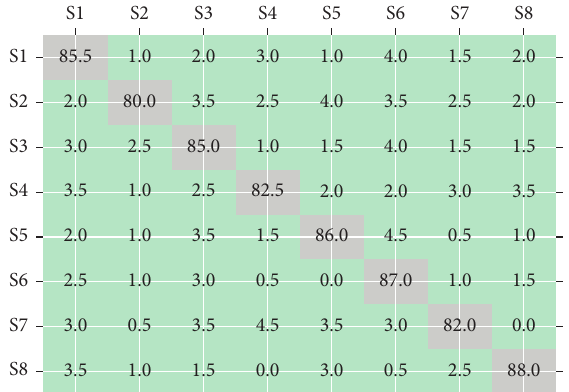
Figure 12: Confusion matrix of speaker identification system. Table 9: Detailed analysis report of the speaker identification system using the proposed approach.